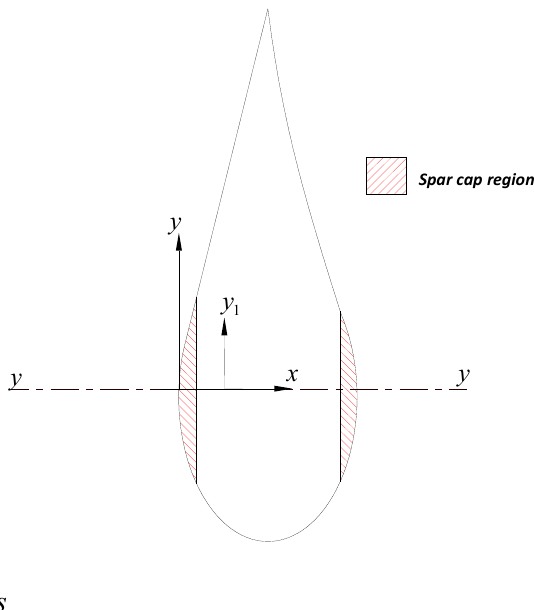
Figure 13. Edgewise bending about yy .